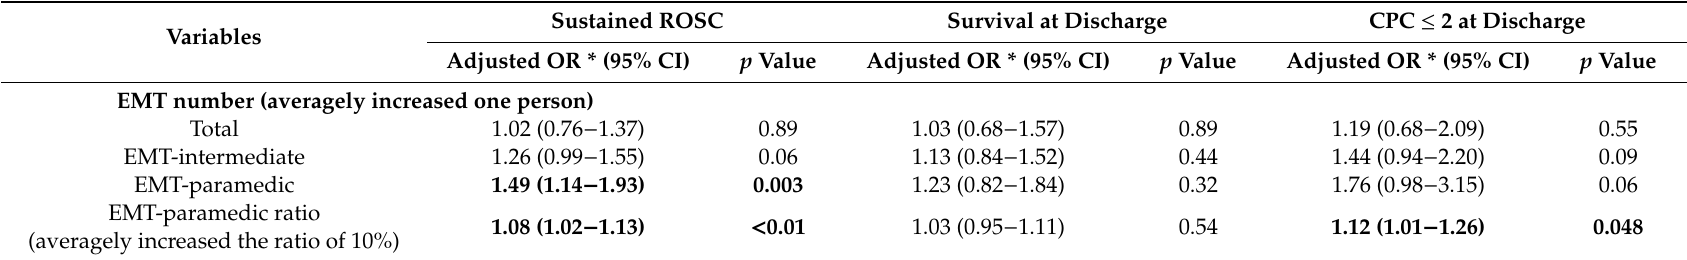
Table 3. Impacts of the crew number and EMT-paramedic ratio on patient outcomes by multivariate analysis.